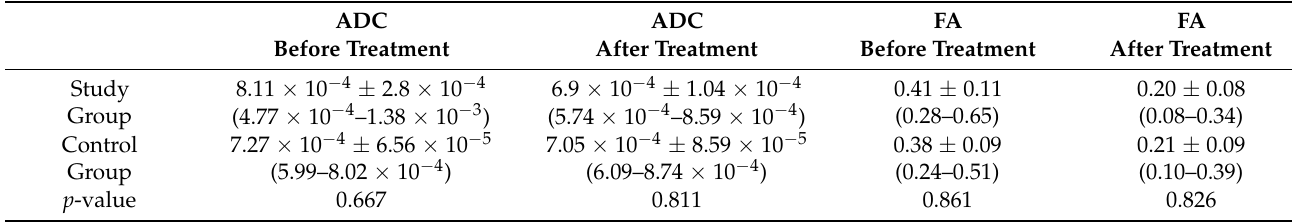
Table 6. ADC and FA values before and after treatment in the study and control group. ADC Before Treatment